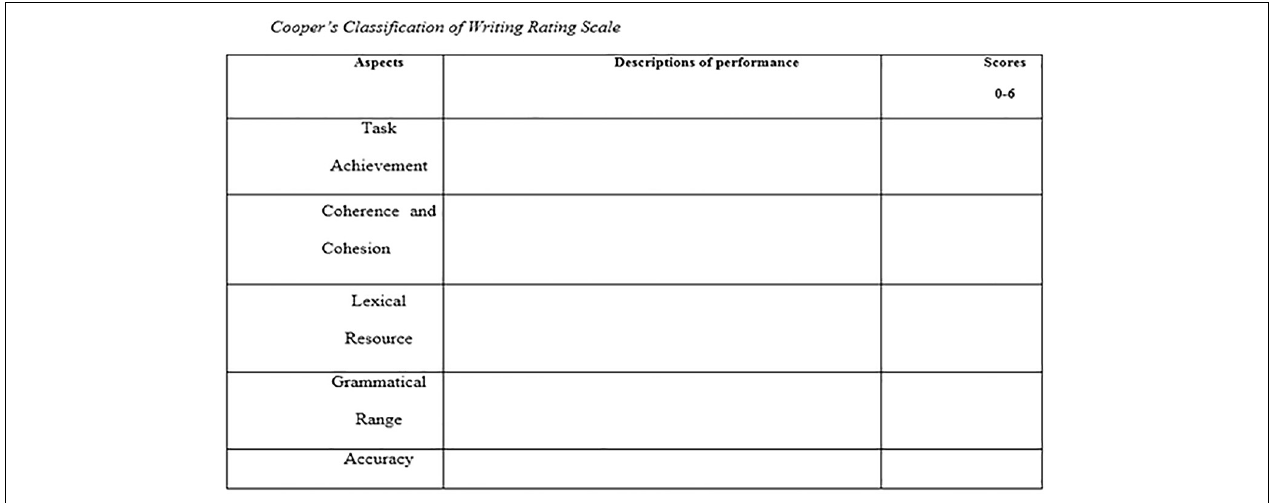
FIGURE 1 | Cooper’s classification of writing rating scale. 6, outstanding; 5, very good; 4, good; 3, adequate; 2, less than adequate; 1, poor; 0, no substantive response.